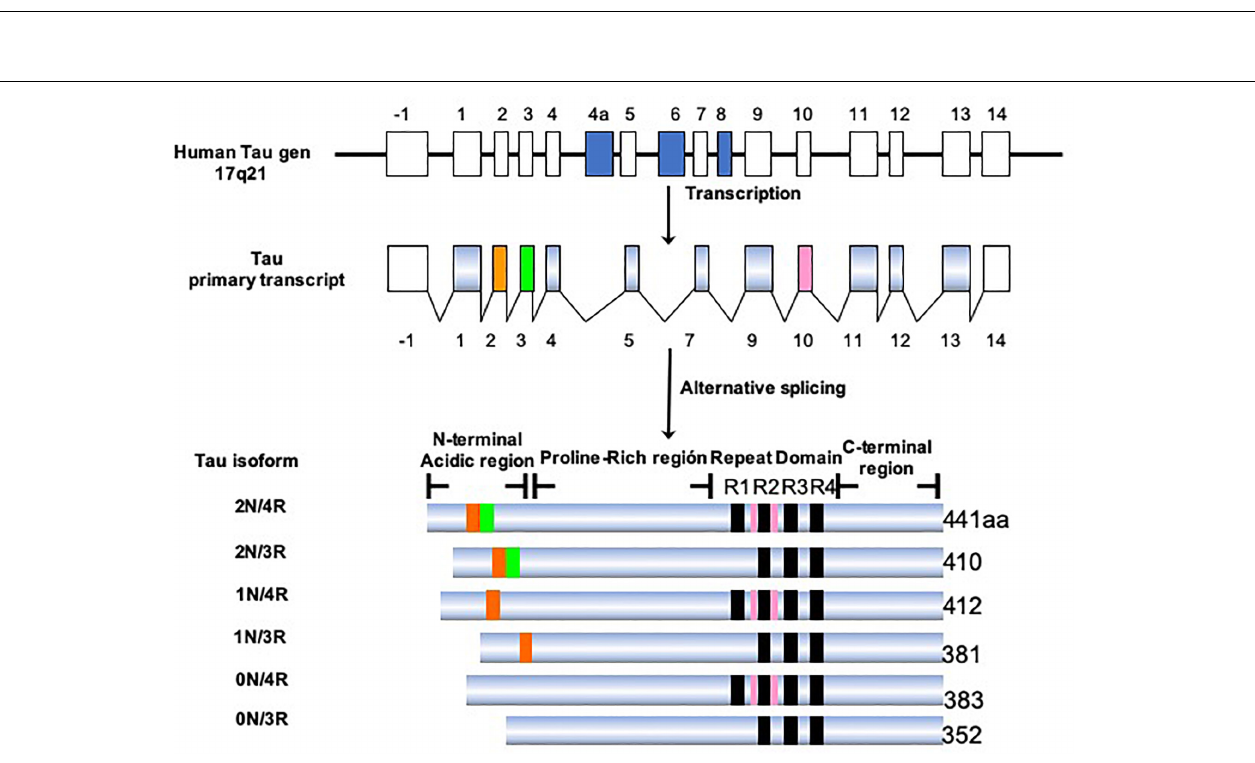
FIGURE 5 | Isoforms of the tau protein. The tau protein gene is located on the long arm of chromosome 17, which generates six isoforms by alternative processing. The longest isoform in the CNS is 441 amino acids and the shortest is 352 amino acids. The length depends on the presence/absence of inserts in the amino terminal portion and the presence of three or four repeated